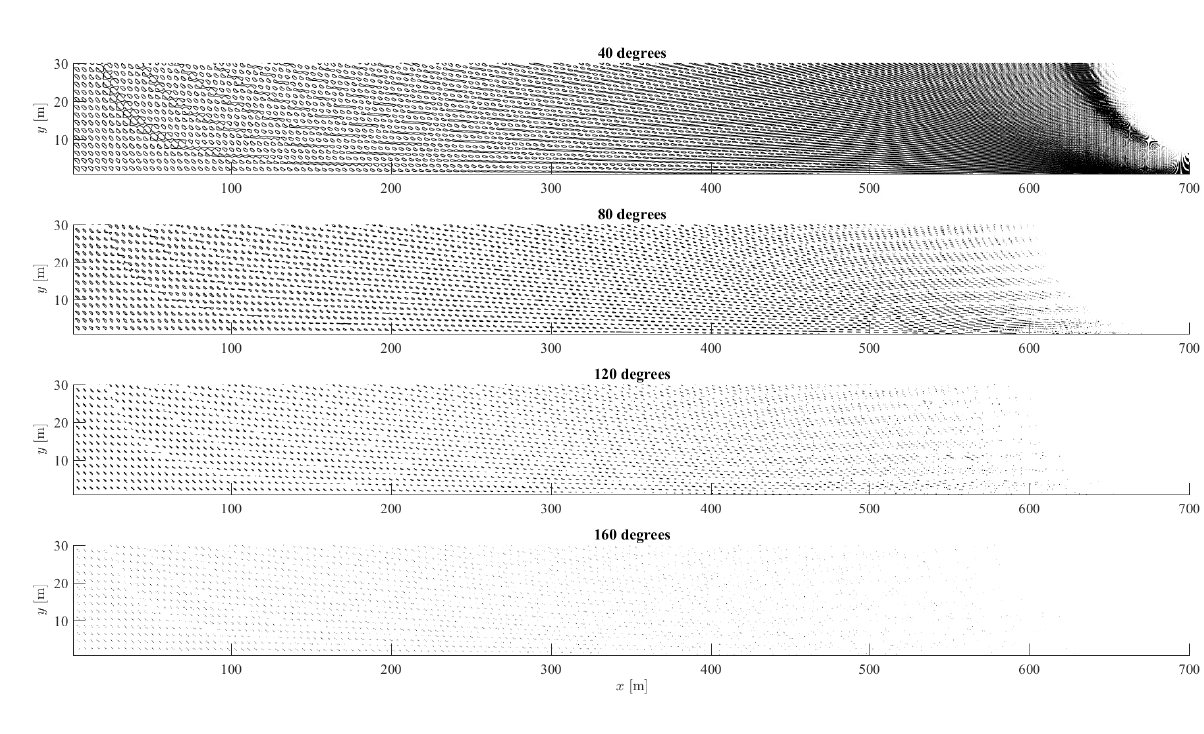
Figure 11: Map of the phase of the multipath factor F as a function of observer position for the same conditions as in the Figure 10.